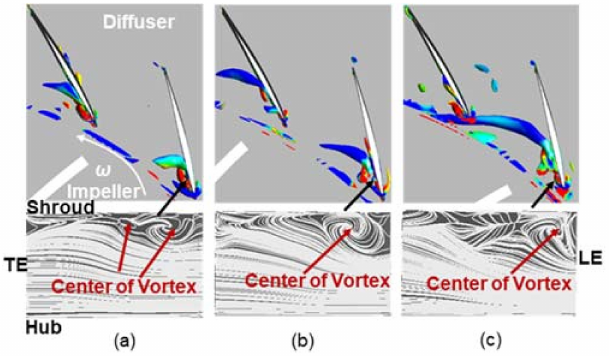
Figure 16. Unsteady behaviour of vortices (TVD, ϕ = 0.7 Q d ): ( a ) t = t 0 ; ( b ) t = t 1 ; ( c ) t = t 2 . The pressure fluctuations at 0.95 span of the leading edge of TVD and SVD (point